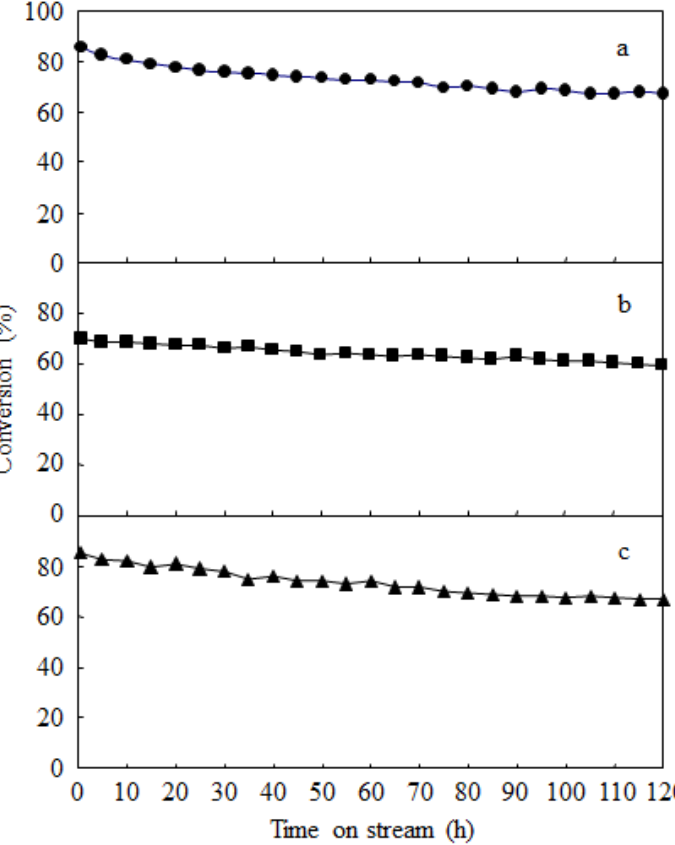
Figure 9. Catalyst deactivation and regeneration for ethanol steam reforming over 7.7 wt % Co/CeO 2 (hp) at 673 K. ( a ) Fresh catalyst; ( b ) the used catalyst (after reaction at 673 K for 120 h) was reduced by H 2 at 673 K for 10 h; ( c ) the used catalyst (after reaction at 673 K for 120 h) was calcined in air at 723 K for 3 h and then reduced by H 2 at 673 K for 10